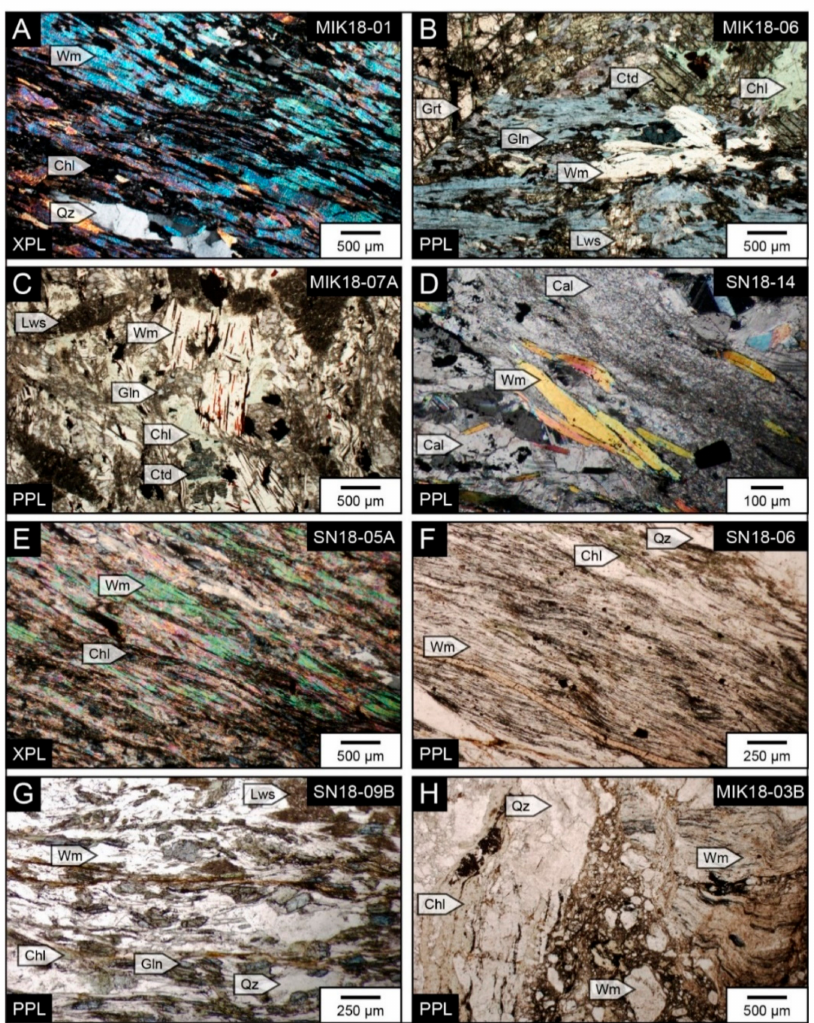
Figure 2. Microphotographs of both the Upper Unit ( A – D ) and Lower Unit ( E – H ) lithologies. ( A ) The foliation of the garnet-white mica schist that is defined by white mica and chlorite interlayers. ( B ) Representation of the high-pressure mineral assemblage. Isolated white mica grains are parallel to the foliation that is defined by the alignment of glaucophane. Chloritoid is partially decomposed to chlorite and lawsonite is partially decomposed to fine-grained polymineralic aggregates. ( C ) Mineral assemblage of the massive blueschists. Glaucophane, chloritoid and lawsonite pseudomorphs are randomly oriented. White mica is typically found as large clusters of randomly oriented grains, sometimes slightly bent or kinked. ( D ) Coarse (lower left) and fine-grained calcite textures of the Upper Unit schistose marbles. The foliation is easily identified by the orientations of white mica, which are slightly kinked and bent. White mica can be found in both coarse and fine-grained domains. The fine-grained layers are oriented parallel to the dominant orientation of white mica. ( E , F ) Phyllitic foliation of the Lower Unit consisting of very finely interlayered white mica and chlorite. Quartz bands are also oriented parallel to the main foliation. Monazite spatially associated with chlorite in the phyllitic foliation. ( G ) Retrogressed blueschist with a foliation defined by white mica and quartz with sparse chlorite grains. Remnants of glaucophane are present and moderately aligned with the foliation. Pseudomorphs after lawsonite are distinguished based on their shape. ( H ) Breccia obtained from the Lower Unit. The angular clasts are composed of quartz-dominated compositions (i.e., left side of photo), calcite-dominated (not depicted) and well-foliated white mica-chlorite interlayers (i.e., right side of photo) that are internally deformed and strongly resemble phyllitic lithologies of the Lower Unit (e.g., microphotograph F). Abbreviations: Cal, calcite; Chl, chlorite; Ctd, chloritoid; Gln, glaucophane; Grt, garnet; Lws, lawsonite; Wm, white mica; Qz,